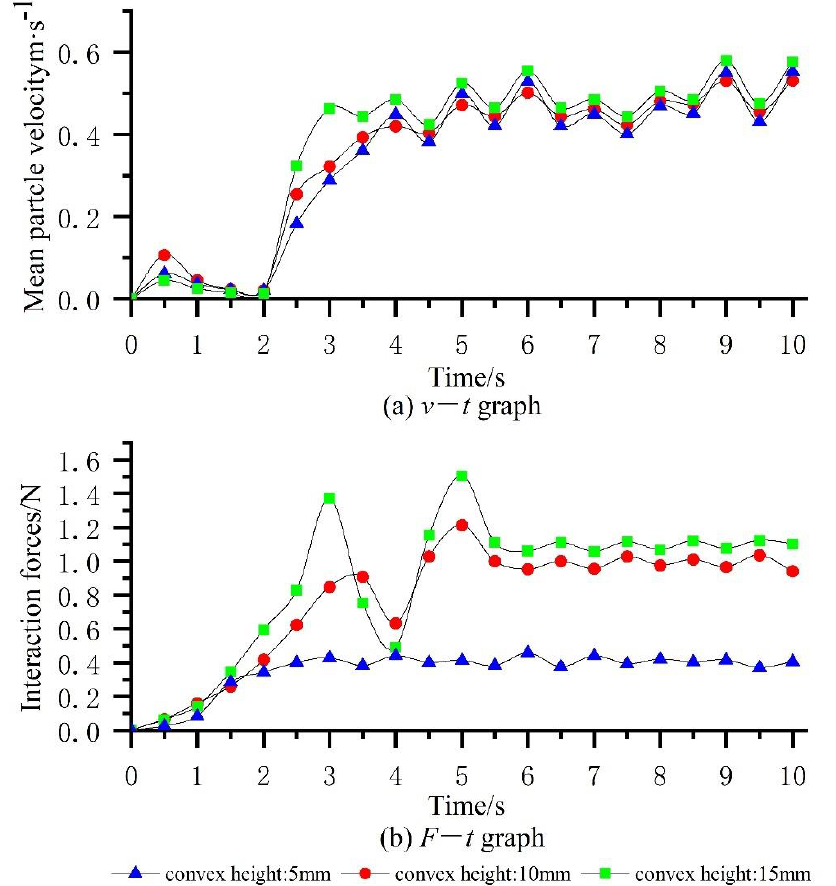
Figure 10. Average velocity and interaction force curves of tea particles at different heights of convex bar.